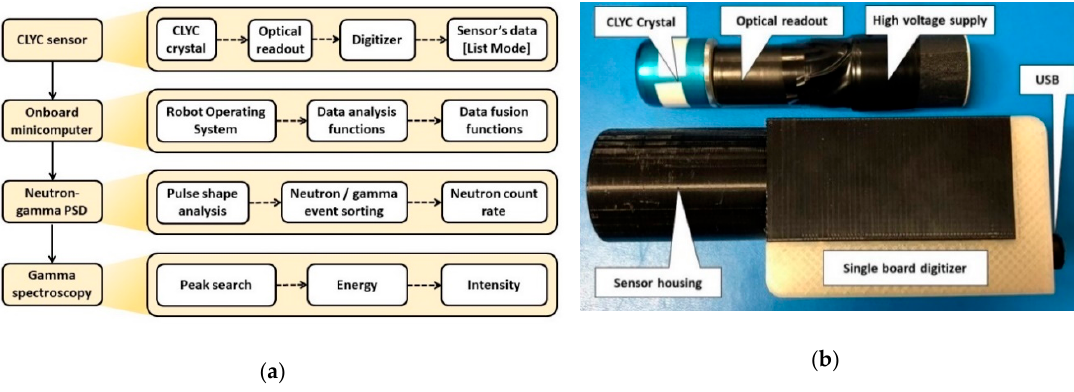
Figure 4. ( a ) Scheme of CLYC sensor operation; ( b ) sensor package.